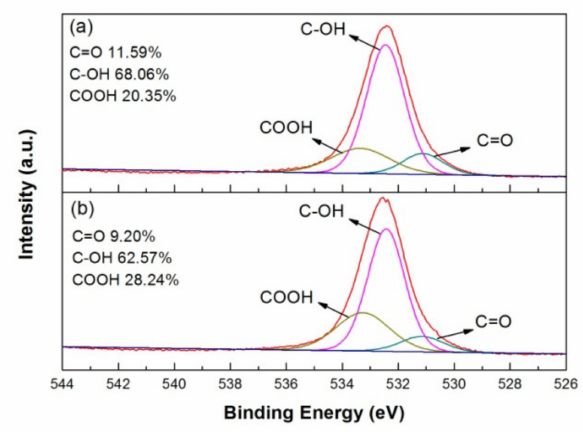
Figure 8. XPS O-1s spectrum and bonding ratio of ( a ) as-deposited and ( b ) 100 ◦ C-annealed rGO / PANI